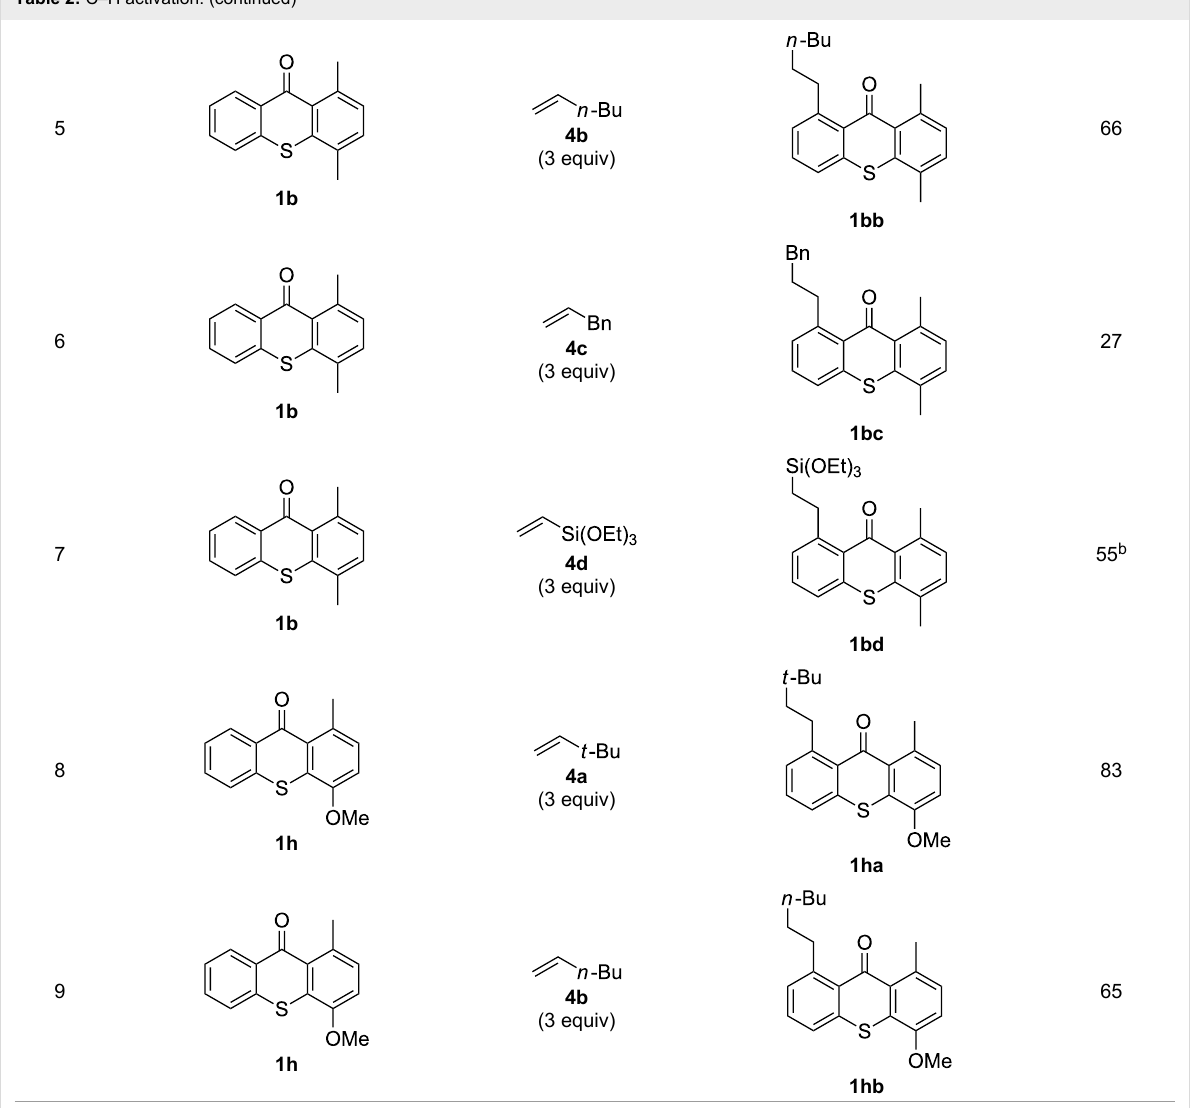
Table 2: C–H activation.